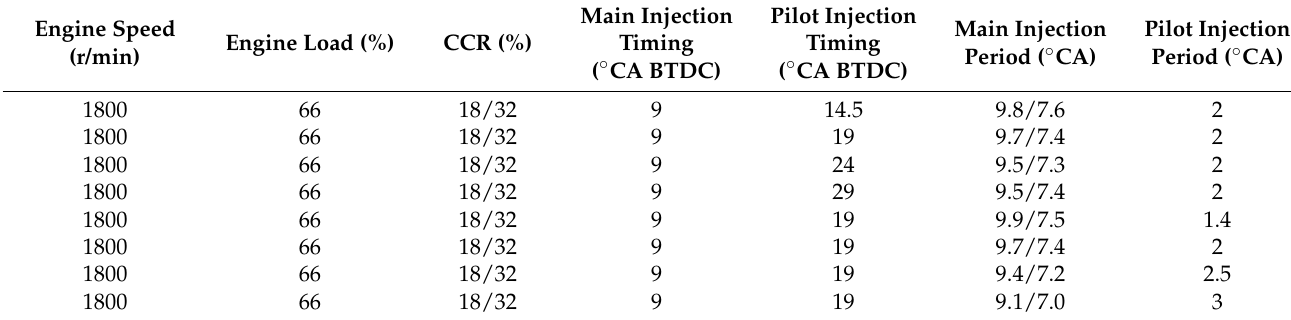
Table 4. The test conditions.